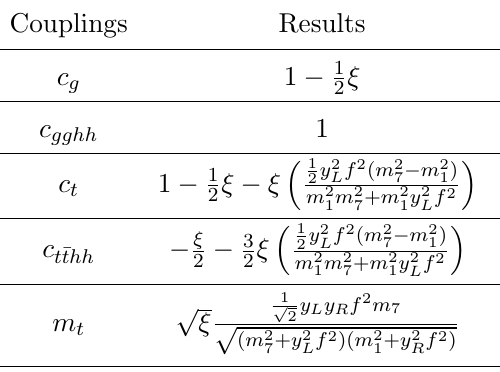
Table 7 . Higgs Couplings and top mass in CTHM of 8 + 1 Representation, which means t L is embedded in the 8 of SO(8) while t R is a singlet. MCHM of 5 + 1 representation is very similar to this case.